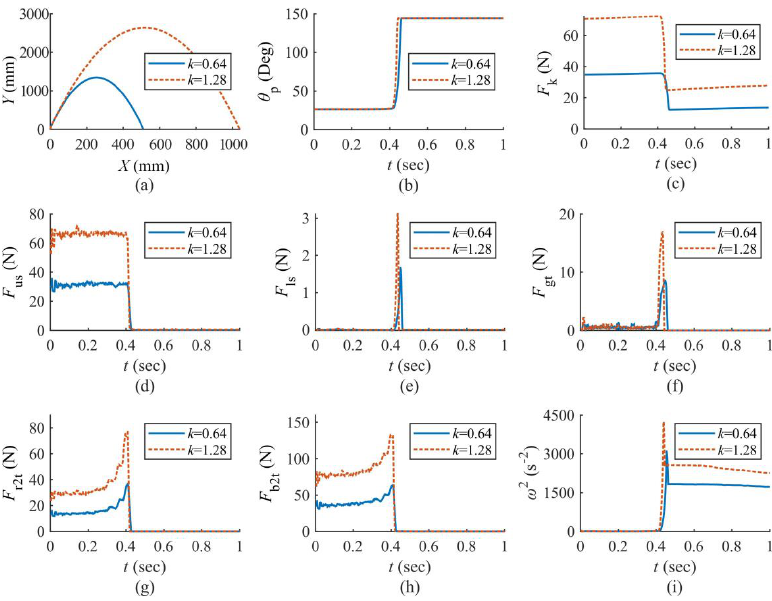
Figure 10. Curves vs. time t [s] of some dynamical parameters, with k = 0.64 and 1.28 N/mm: ( a ) orbit of COM of the mechanism [displacement on y axis (Y) vs. displacement on x axis (X)]; ( b ) time-varying trend of θ p ; ( c ) time-varying trend of elastic force in serried springs ( F k ); ( d ) time-varying trend of tension force in upper string ( F upstr ); ( e ) time-varying trend of tension force in lower string ( F lowstr ); ( f ) time-varying trend of tangential component of contact force between pole and ground ( F gt ), equal to friction force between mechanism and ground (normal component of this force has the same trend after subtracting the weight of the mechanism); ( g ) time-varying trend of interaction force between RS and TS ( F r2t ); ( h ) time-varying trend of interaction force between support board (SB) and TS ( F b2t ); ( i ) squared angular velocity of motor ( ω 2